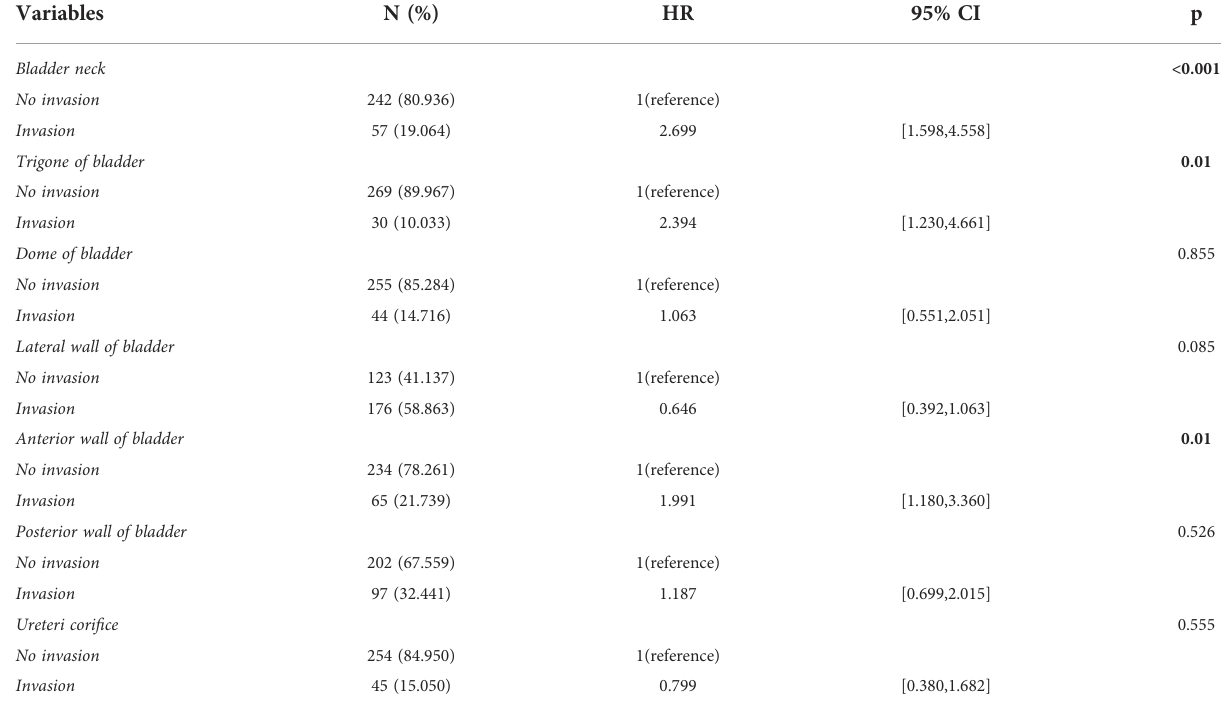
TABLE 2 Baseline characteristics and univariable Cox regression analysis of tumor invasion locations.